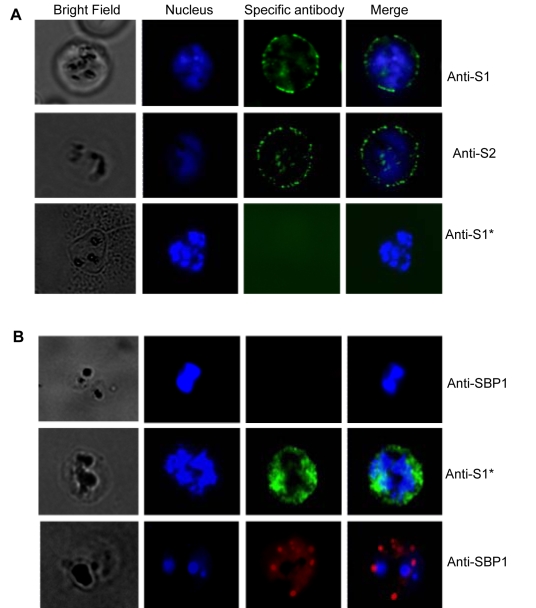
Location of native STEVOR at the iRBC surface.(A) Immunofluorescence assay of live 5A-infected erythrocytes with anti-S1 (upper row) and anti-S2 (middle row) antisera recognizing native STEVOR at the iRBC surface. Either anti-S1 or anti-S2 (lower row) did not react with trypsinized iRBC. The specific antibodies that reacted with the iRBC surface were detected with Alexa Fluor–labeled goat anti-rabbit IgG. Successive columns from left to right denote bright field, parasite nucleus staining, specific antibody staining (shown in the right), and merge images. (B) Immunofluorescence assay of live 5A-infected erythrocytes with anti-SBP1 (upper row) showing lack of staining of the iRBC. Middle and lower rows showed, respectively, anti-S1 (or anti-S2) and anti-SBP1 staining after SLO-permeabilization of the infected RBC. The specific antibodies that reacted with the iRBC surface were detected with Alexa Fluor–labeled goat anti-rabbit (or anti-mouse) IgG. The fluorescent images (individual stains and merged) and the bright-field are shown. * denotes that the same staining pattern was observed with anti-S2 antibody.